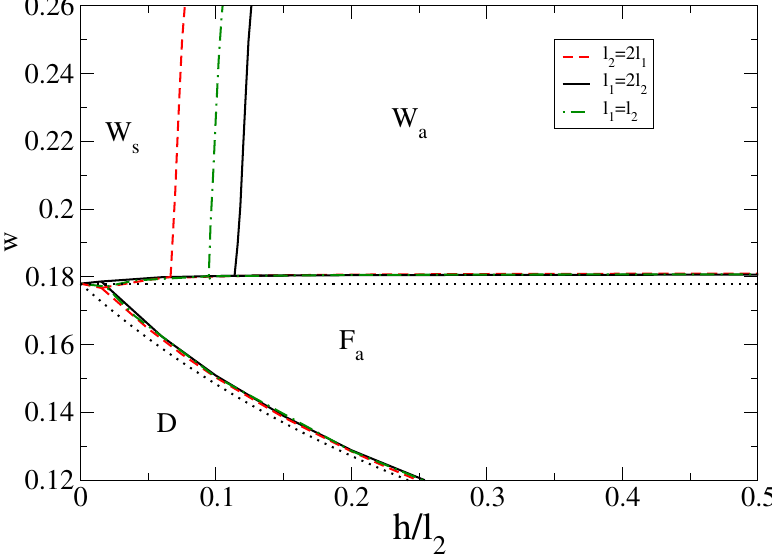
Figure 4. Interfacial phase diagram of a nematogen at the nematic–isotropic coexistence in contact with a crenellated substrate of period λ = 10 5 and l 1 = 2 l 2 (black continuous lines), l 2 = 2 l 1 (red dashed lines) and l 1 = l 2 (green dot-dashed lines). The black dotted lines correspond to the phase boundaries in the limit λ → ∞ .